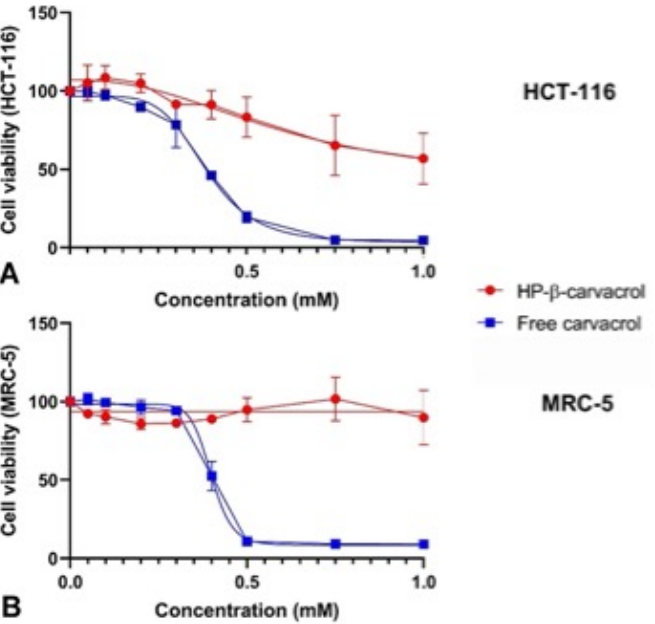
Figure 11. The dose-dependent effect of carvacrol and HP- β -CD-carvacrol complexes on ( A ) HCT-116 colorectal cancer cells and ( B ) MRC-5 lung fibroblast cells, with viability (72 h incubation). The data shown represent the averaged and SD values of the triplicates.